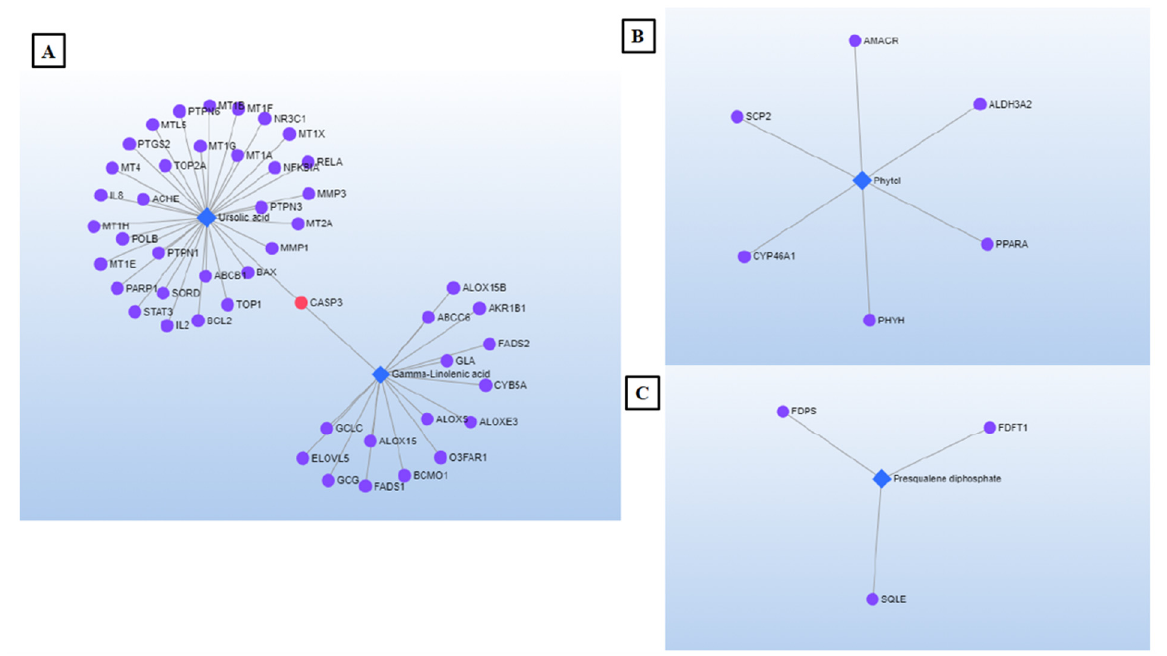
Figure 5. ( A – C ). Graphs of the selected interaction networks.